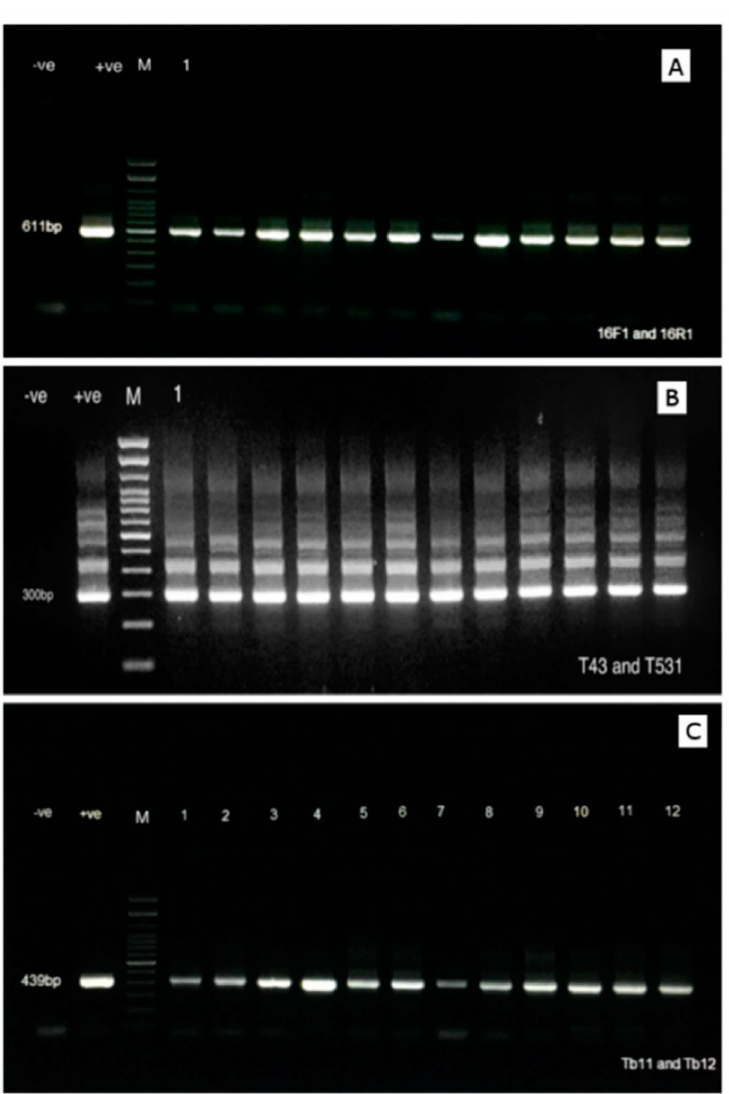
Figure 1. Agarose gel electrophoresis showing the amplicons generated by the various PCR conducted on the positive samples through the 3 di ff erent procedures: ( A ) 611 bp amplicon product generated using the PCR procedure described by Delghandi et al. [34]; ( B ) 300 bp amplicon generated